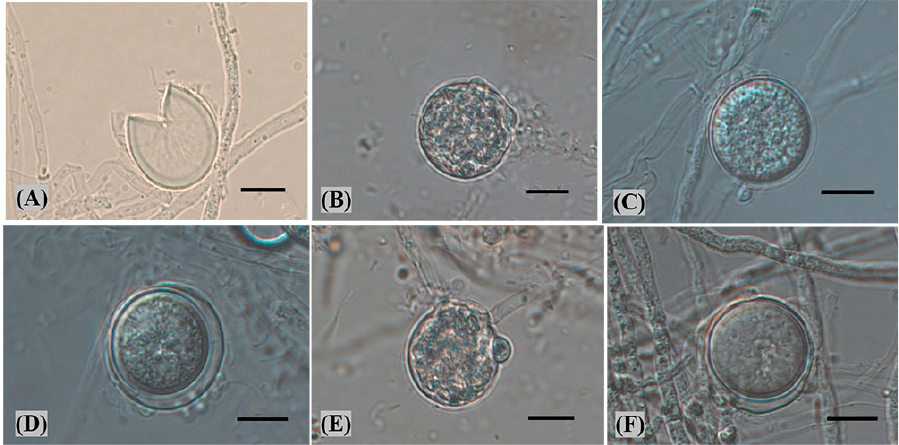
Figure 4. ( A ) Empty sporangia. ( B , C ) Sporangia. ( D , F ) Sexual structures showing an oogonia and